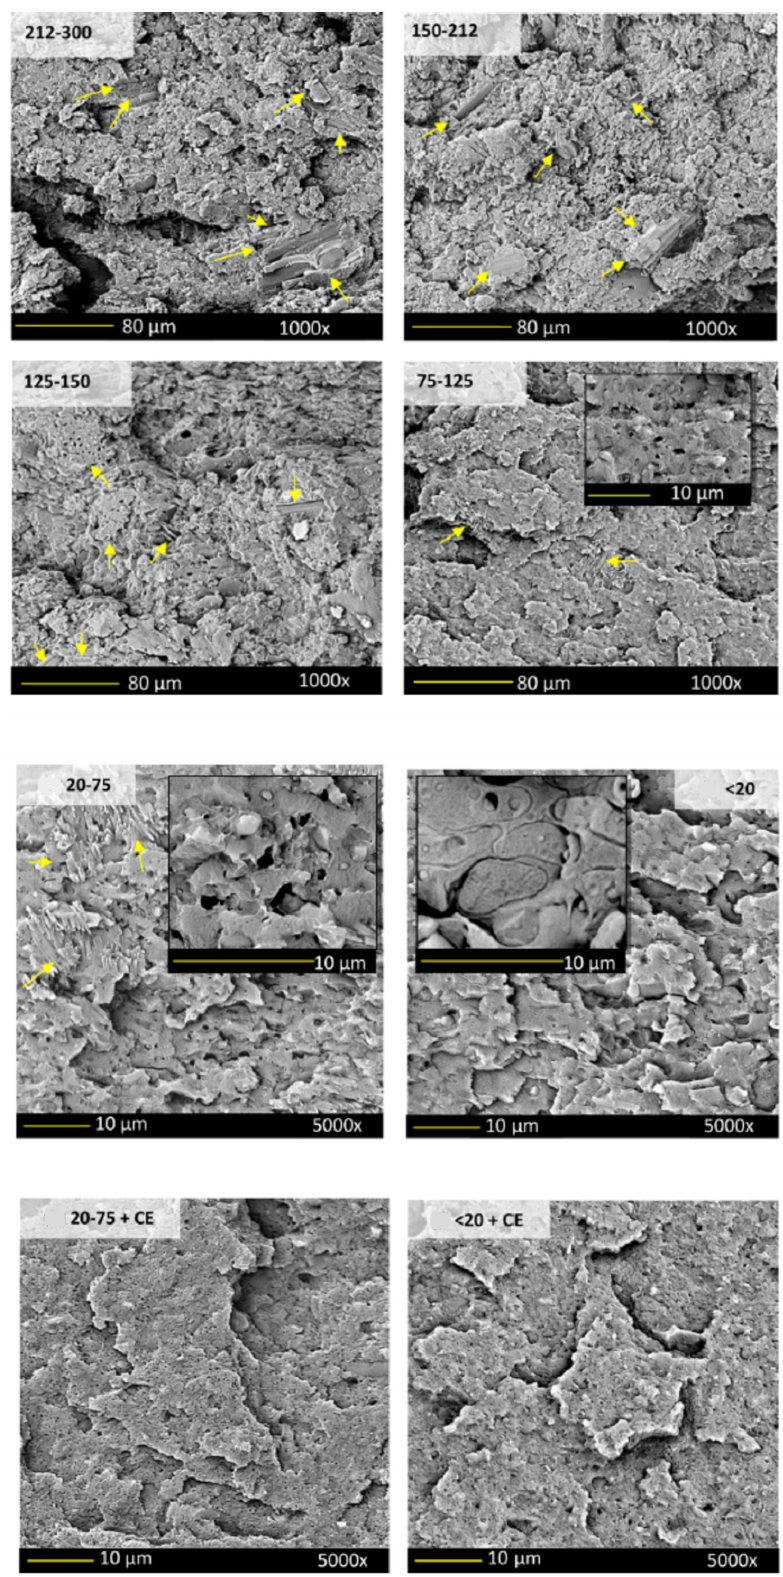
Figure 8. Morphology of composites with different size-fractionated BC (the arrows point to BC particles) [104]. Reproduced with permission from the American Chemical Society. 2016, American Chemical